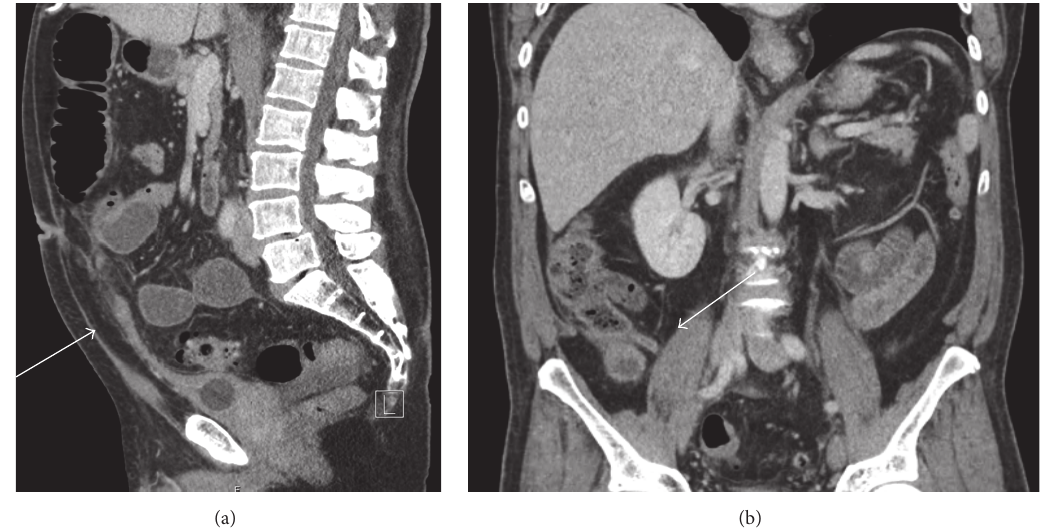
Figure 1: CT scan demonstrating a Foley catheter in the decompressed bladder with (a) demonstration of a urachal cyst connection from the anterior reflection of the bladder to the umbilicus with dilated small bowel loops and adjacent fat stranding and (b) a normal appearing posterior appendix off the cecum.